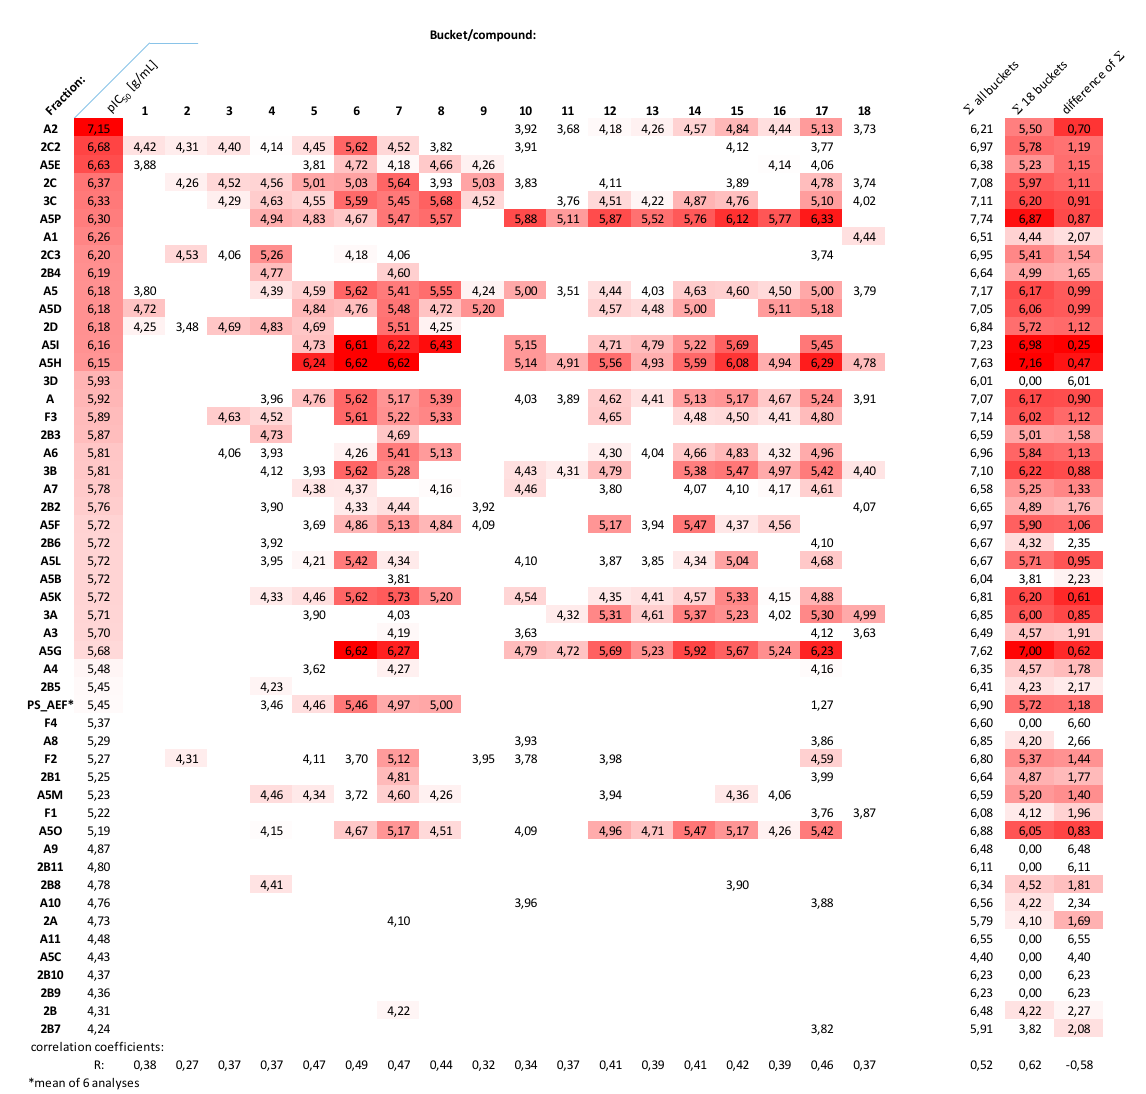
Figure 6 . Heat map representation of the distribution and amount (log values of bucket intensity values) of the 18 selected compounds in the various fractions in relation to their anti-Tbr activity ( − log IC 50 (g/mL) = pIC 50 ), with a more intense red indicating higher activity and higher intensity. Correlation coefficients with the pIC 50 values are shown for each individual compound, for the sum of logarithmic total intensity of all buckets, for the sum of the 18 selected compounds/buckets’ intensity data, as well as for the difference between these two sums representing the log value of the fraction of the 18 compounds to the total of each fraction.